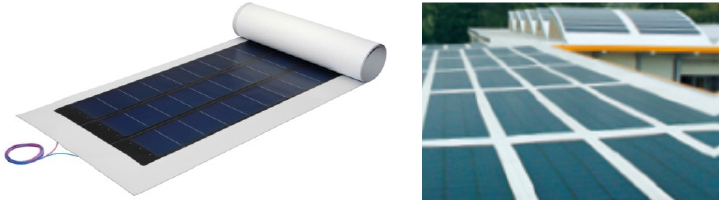
Figure 3. Example of a BIPV foil product from Alwitra GmbH & Co. using amorphous silicon cells from Uni ‐ Solar [21].